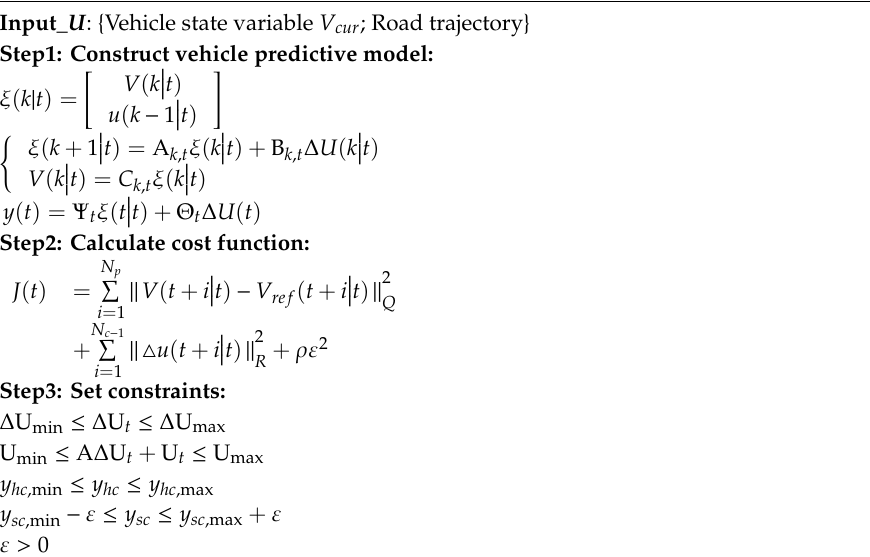
Algorithm 1. MPC